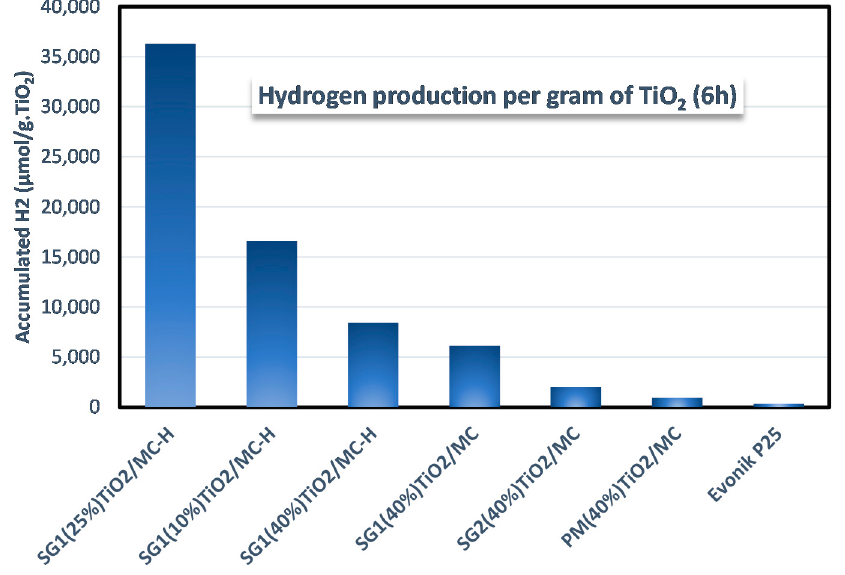
Figure 7. Accumulated hydrogen production after 6 h of reaction expressed as µmol of H 2 per gram of TiO 2 for all the photocatalysts used in this work.